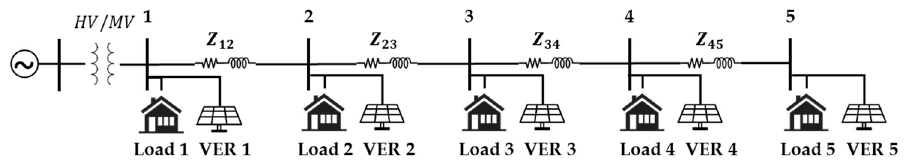
Figure 1. Distribution system with multiple buses.